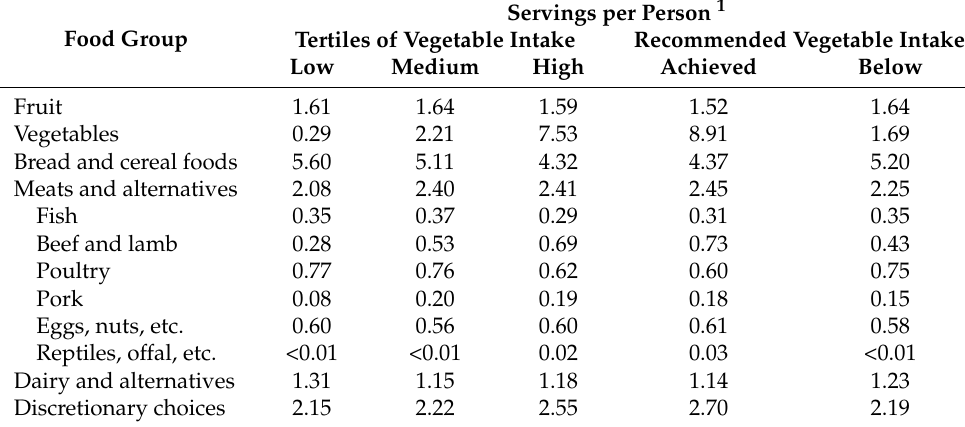
Table 4. The higher diet quality/lower environmental impact (HQLI) subgroup of adult (19 years old and above) daily diets in Australia: food intake (servings person − 1 ) for the low, medium, and high vegetable intake tertiles, for those diets achieving the Australian Dietary Guidelines’ recommended intake for vegetables, and those diets below recommended vegetable intake 1 .